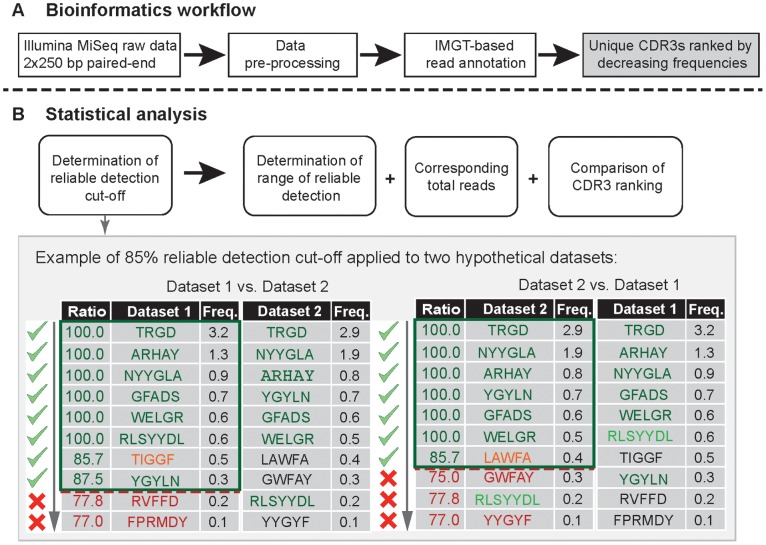
An overview of bioinformatics workflow and statistical analysis performed on antibody HTS datasets.(A) Bioinformatics steps following the HTS of antibody libraries and preceding the data analysis. Sequences were pre-processed and IMGT-annotated reads were filtered for (i) CDR3s of minimal length of 4 amino acids and (ii) CDR3 and VDJ regions present with a minimal abundance of 2 in order to exclude errors introduced during library preparation or HTS reaction. Abundances were calculated based on occurrence of exact amino acid sequences (100% identity, see Methods). (B) Statistical analysis detailing the principle of reliable detection as applied in this study. CDR3 clones were ranked in decreasing order of frequency and tested for simultaneous presence in the other dataset(s). The principle is demonstrated using two hypothetical datasets of 10 different (unique) CDR3s with an exemplary reliable detection cut-off of 85% (throughout this study 95% was used). Specifically, from each dataset a list of reliably detected clones was generated (clones in green box) by sequentially adding the highest frequency clones to a list, until the addition of the next clone would reduce the percentage of clones present in the other dataset(s) below the set threshold (marked by the red dashed line). All further clones of lower rank were not included in the list and therefore not reliably detected (red color). Orange indicates clones that are not present in the other dataset(s) but were nevertheless included in the list of reliably detected CDR3s via the 85% detection cut-off. The list of reliably detected CDR3s allowed downstream analyses such as the determination of the range of reliable detection (frequency and abundance ranges), the calculation of the percentage of total reads corresponding to the reliably detected CDR3s, and the comparison of CDR3 rankings.